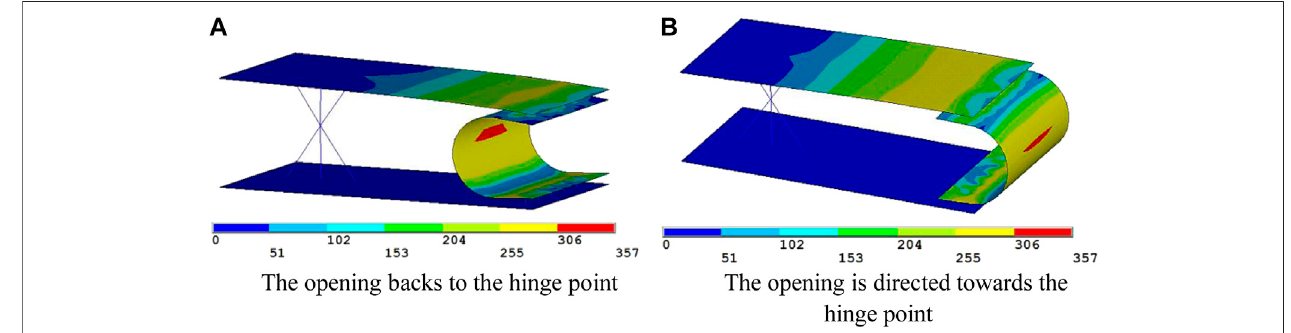
FIGURE 11 | Stress nephogram. (A) The opening backs to the hinge point. (B) The opening is directed towards the hinge point.